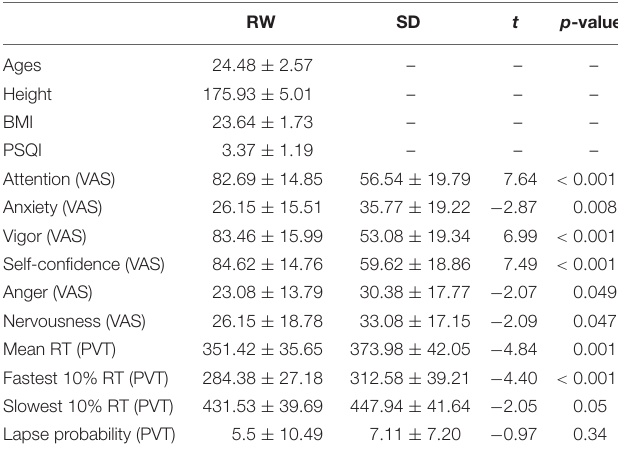
TABLE 1 | Demographic data, sleep quality index, and psychological traits ( n =